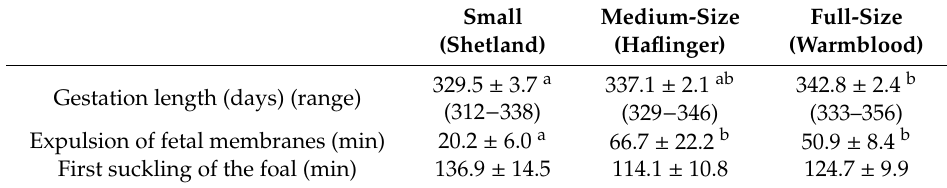
Table 2. Gestation length, time from birth of the foal to expulsion of fetal membranes and time to first suckling the mare’s udder in small, medium-size and full-size mares and their newborn